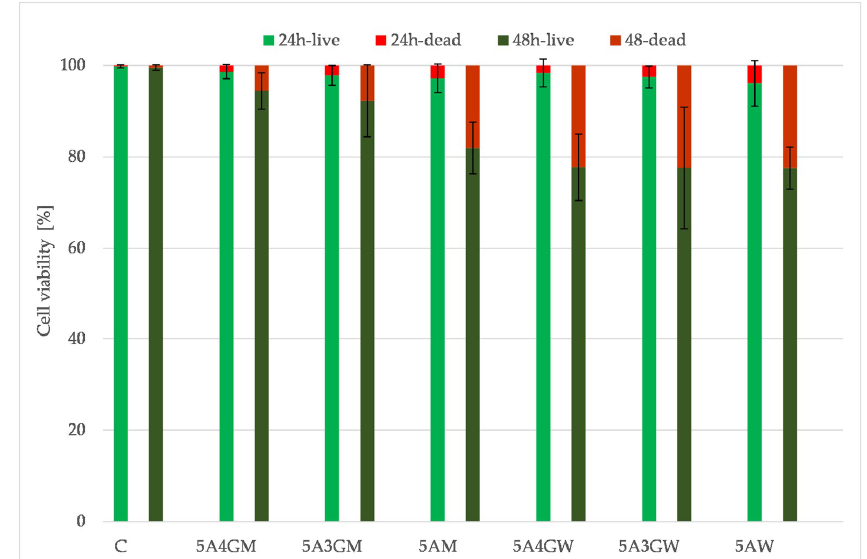
Figure 7. Endothelial cells (EA.hy 926 line) viability after direct contact with samples dissolved in water (W) and full culture medium (M) with different content of gelatine after 24 and 48 h of incubation.